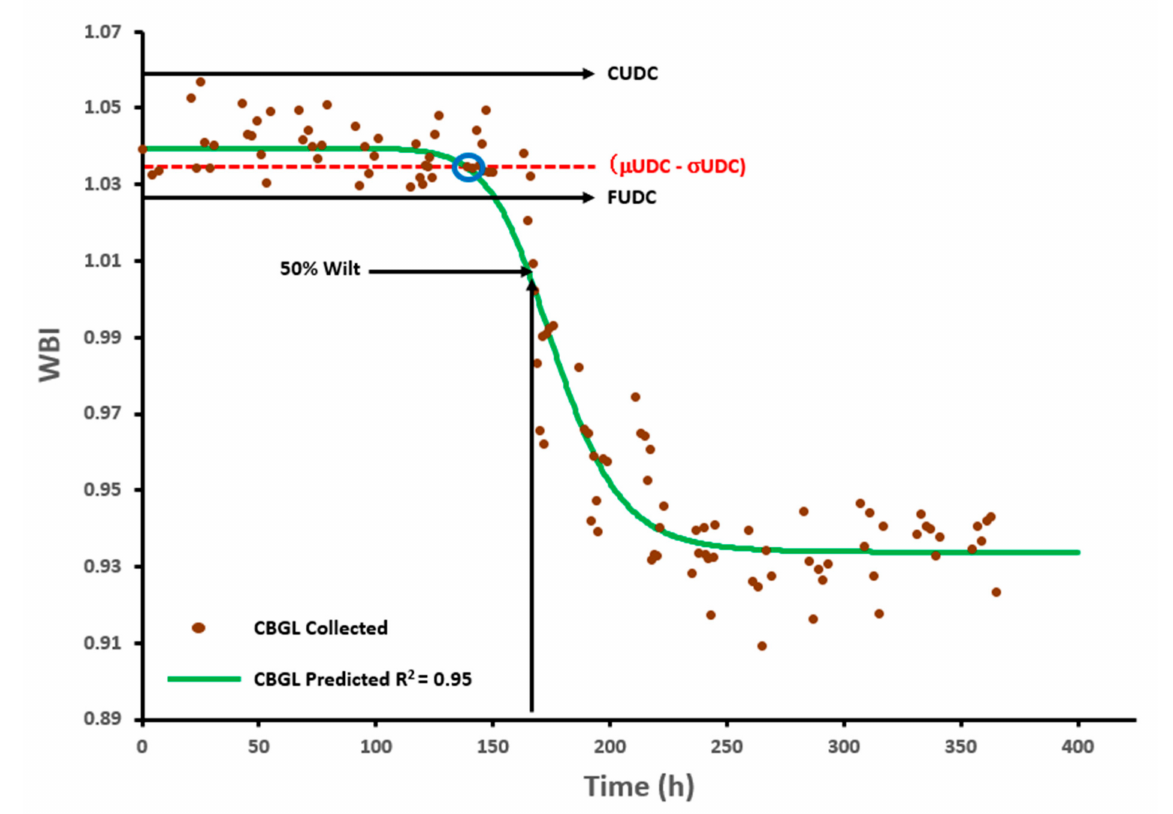
Figure 4. Four-parameter nonlinear logistic regression analysis of spectral reflectance data gathered from ‘007’ creeping bentgrass (CBG) established in a loam (L) soil and of one dry-down cycle subjected to greenhouse conditions in Blacksburg, VA. The water band index (WBI = R 900 /R 970 ) is plotted against the time (h) from initiating the dry-down cycle to illustrate the relationship to soil moisture stress over time. To eliminate variability for wilt prediction, mean values ( µ ) and standard deviation ( σ ) within the floor and ceiling of upper data cloud (FUDC and CUDC, respectively) were calculated. The blue circle represents the estimated point of a plant physiological response to soil moisture stress derived from the difference of the µ UDC and one σ UDC. The hours where 50% wilt occurred is subtracted from hours of the adjusted value to provide the total wilt prediction time